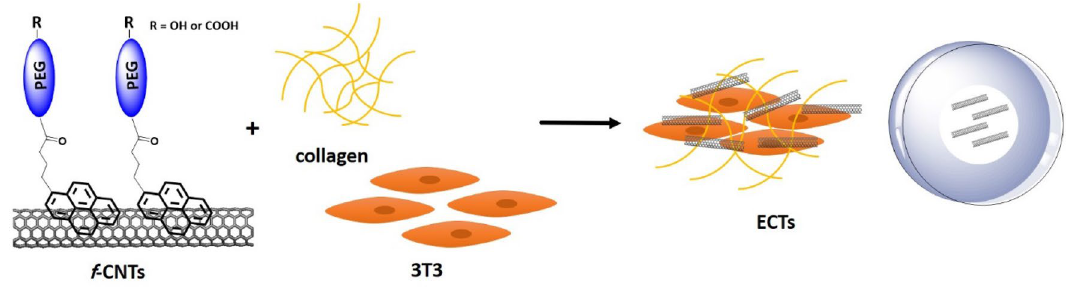
Figure 1. Schematic representation of the engineered connective tissue based on the non-covalent functionalization of the